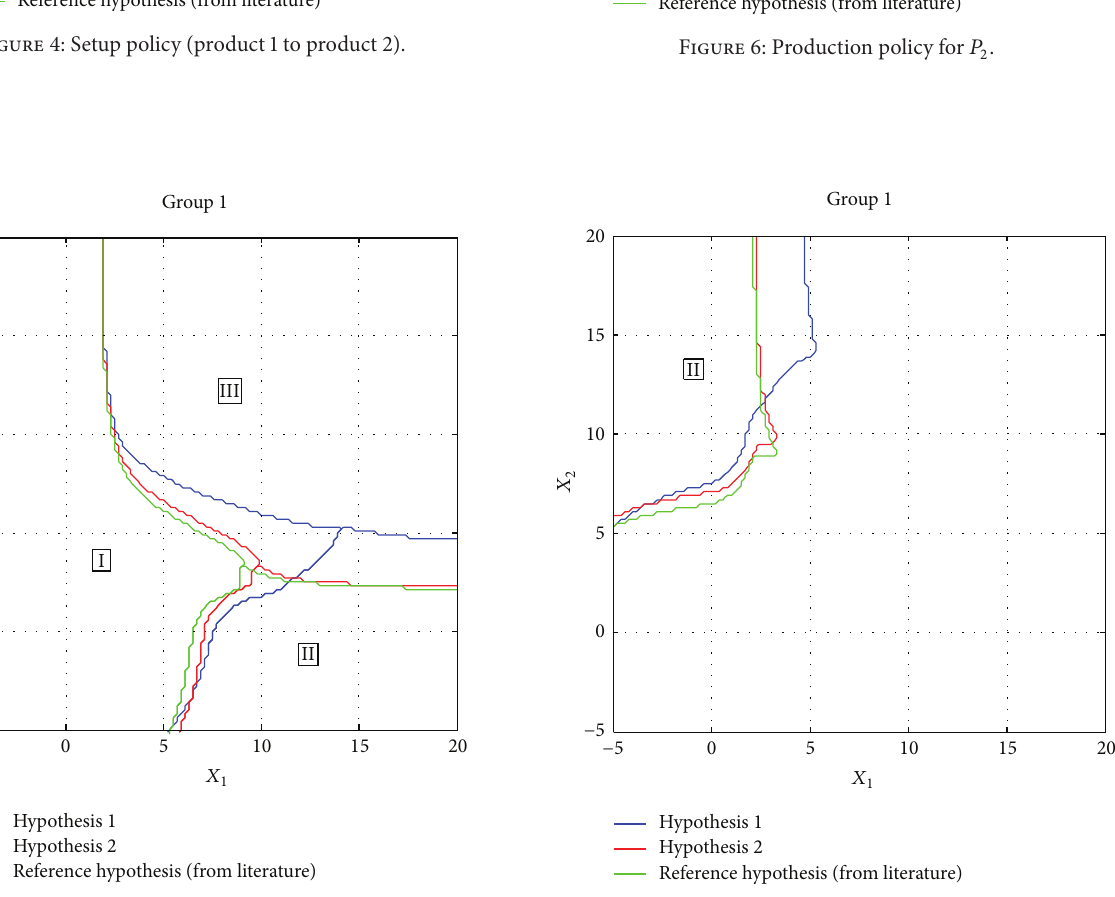
Figure 7: Setup policy (product 2 to product